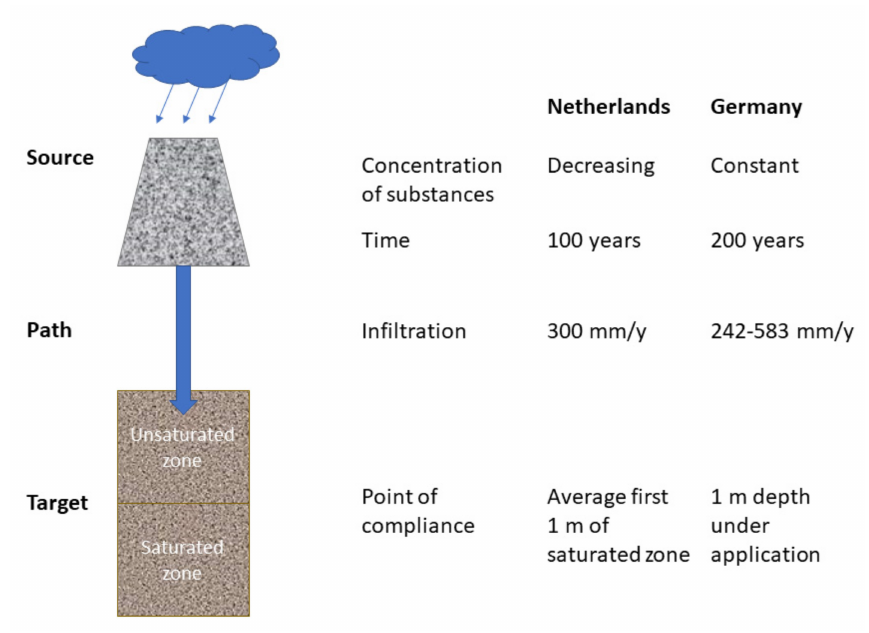
Figure 7. Different definitions of parameters in scenarios for risk assessments in the Netherlands and Germany (adapted and simplified from